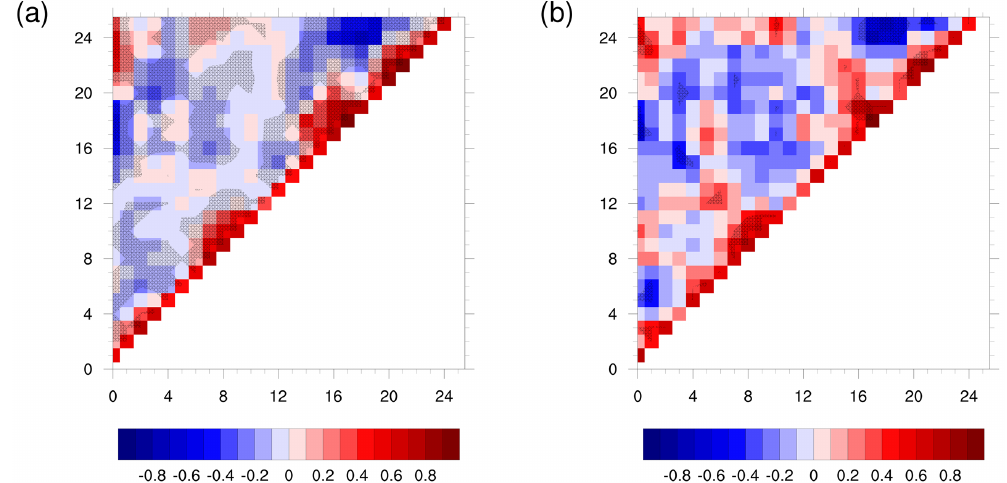
Figure 3. (a) CESM-simulated inter-basin annual integrated precipitation correlation coefficients (colored squares). Horizontal and vertical axes: Antarctic Ice Sheet basin number (Fig. 1). (b) RACMO-simulated inter-basin annual integrated precipitation correlations. Stippling indicates significance at the 95% level. Main diagonal (correlations of basins with themselves) and duplicate correlations are excluded.